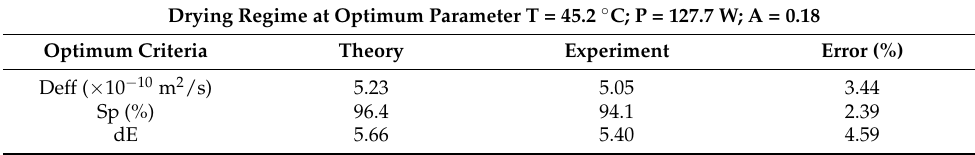
Table 2. Comparison of experimental and theoretical results at optimal drying